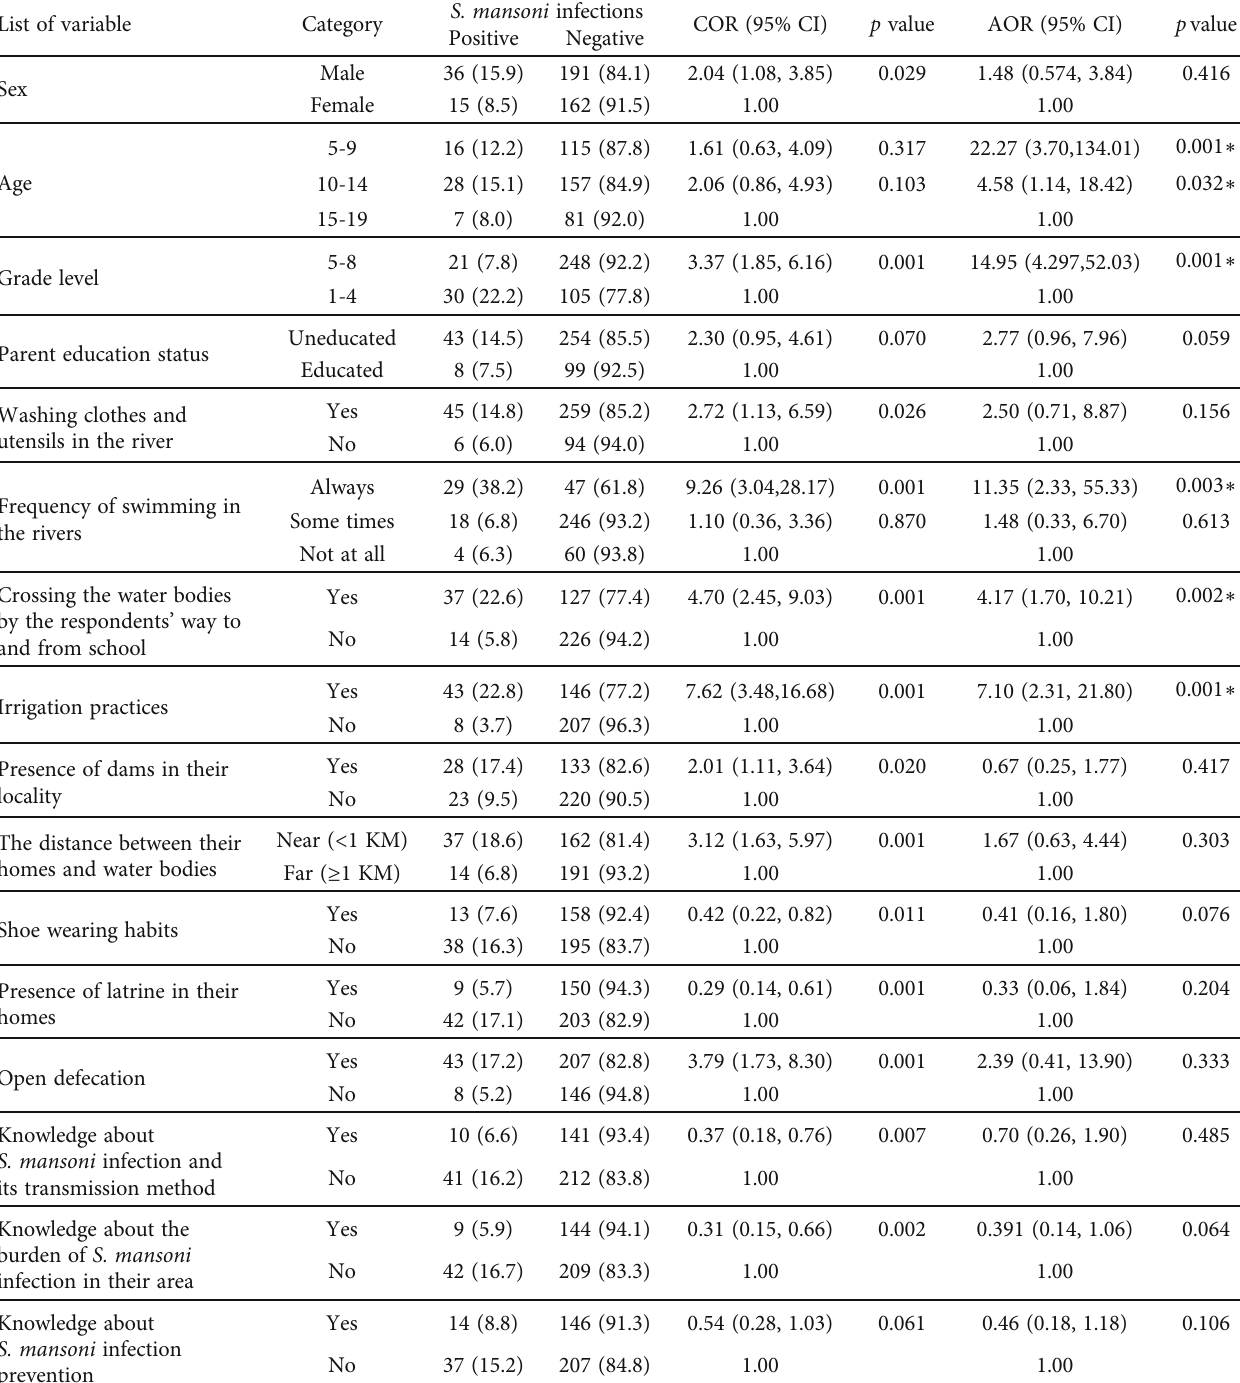
Table 3: Multivariate logistic regression analysis of Schistosoma mansoni prevalence with selected seemingly signi fi cant variables in Gichgich and Kibi, Guangua district, northwest Ethiopia